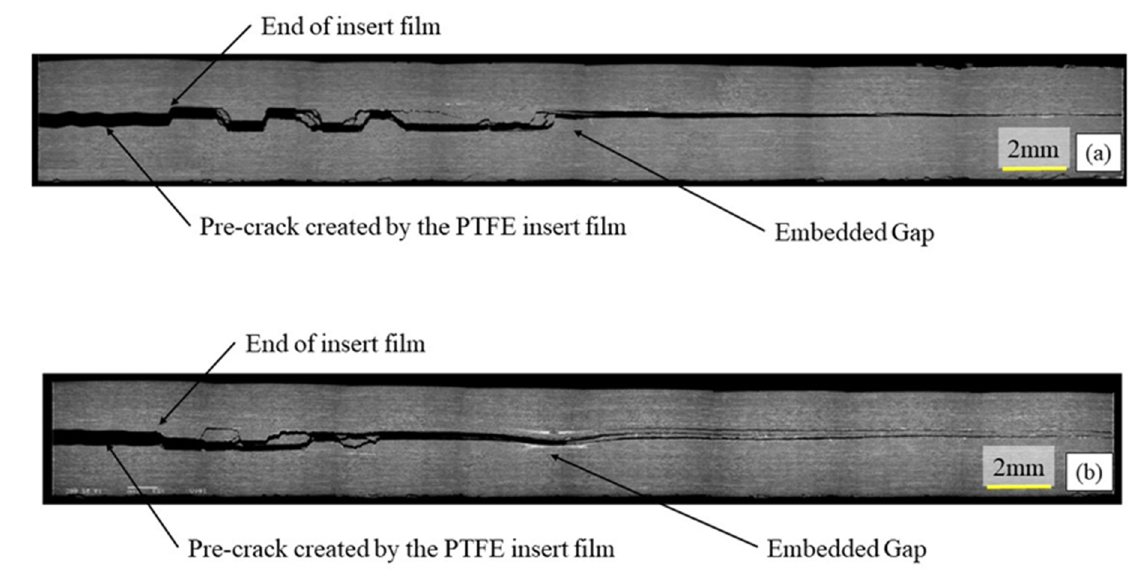
Figure 17. Examples of Mode I crack propagation paths for tests on ( a ) gap 0.5 mm, with caul plate, ( b ) gap 6.35 mm, with caul plate.